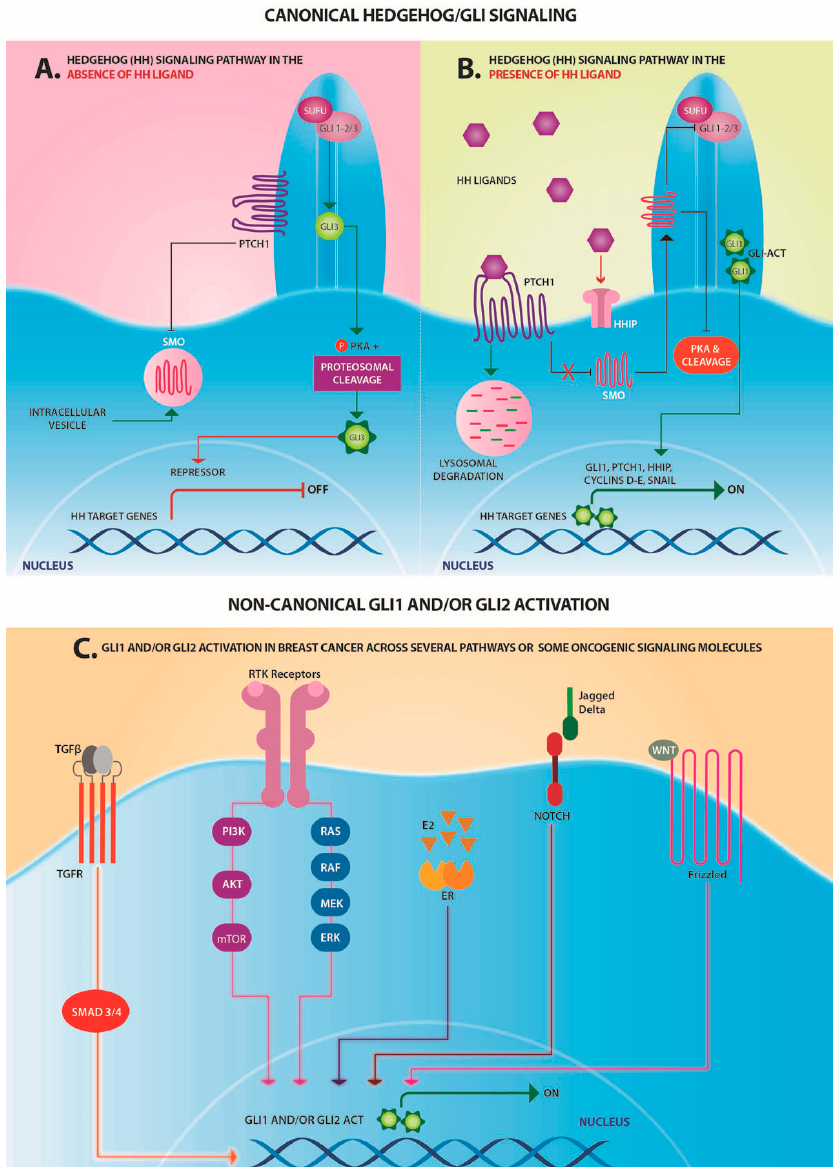
Figure 7. Simplified representation of canonical and non-canonical Hedgehog(HH) signaling. Canonical activation of the HH pathway. ( A ) In the absence of HH ligand, PTCH1 present in the primary cilium prevents Smoothened (SMO) trafficking and localization to the cilia. GLI mediators are in complex with proteins, including protein kinase A (PKA) and suppressor of fused homolog (SUFU), and generate repressor GLI forms, which translocate to the nucleus and inhibit transcription of HH signaling target genes; ( B ) In the presence of HH ligand, ligand binding to PTCH1 leads to PTCH1 internalization and degradation, SMO can traffic to the cilium and initiate a signaling cascade that processes the GLI proteins into transcriptional activator forms, which translocate to the nucleus and activate the expression of HH signaling target genes; ( C ) Activation of GLI1 and GLI2 in breast cancer by non-canonical pathways. Regulatory signaling cascades or regulatory proteins other than canonical Hedgehog signaling can modulate GLI1 and GLI2 expression, transcriptional activity and stability. Transforming growth factor β /transforming growth factor receptor (TGF β /TGFR) signals can induce transcriptional up-regulation of GLI1 and GLI2 via SMAD. Receptor tyrosine kinases (RTK) signals via the PI3K-AKT signaling cascade can induce stabilization of the GLI1 protein. In ER α -positive breast cancer cells E2 induces expression of SHH and GLI1 independent of SMO activity. WNT signaling activation stimulates GLI2. GLI2 ACT, the activator form of GLI2.